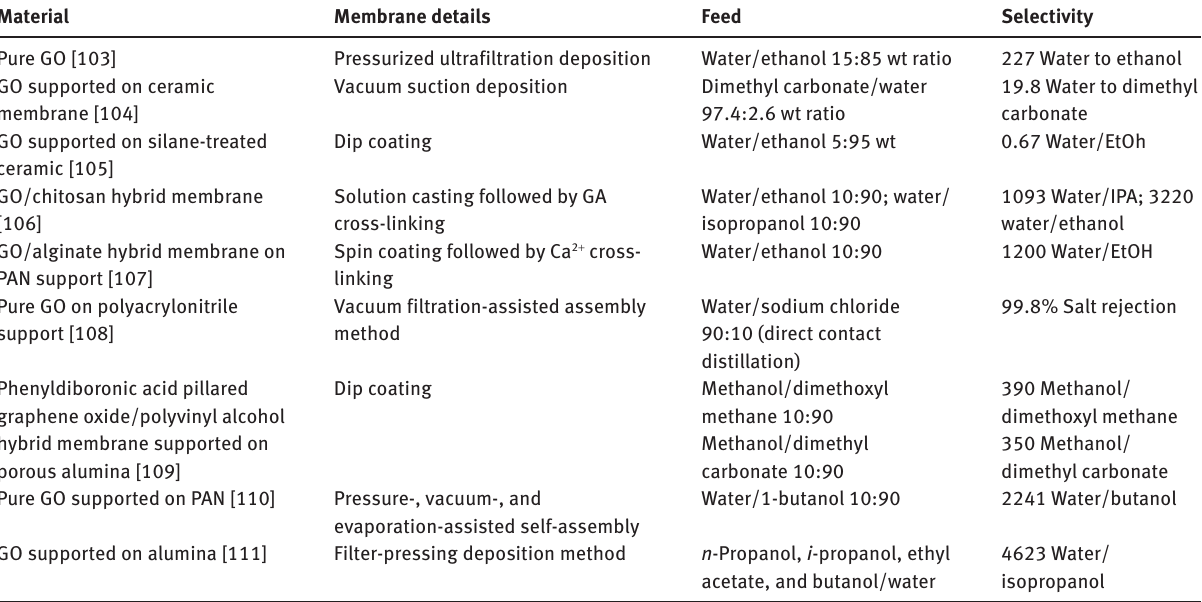
Table 2: Applications of GO and graphene hybrid composite membranes in separation technologies.